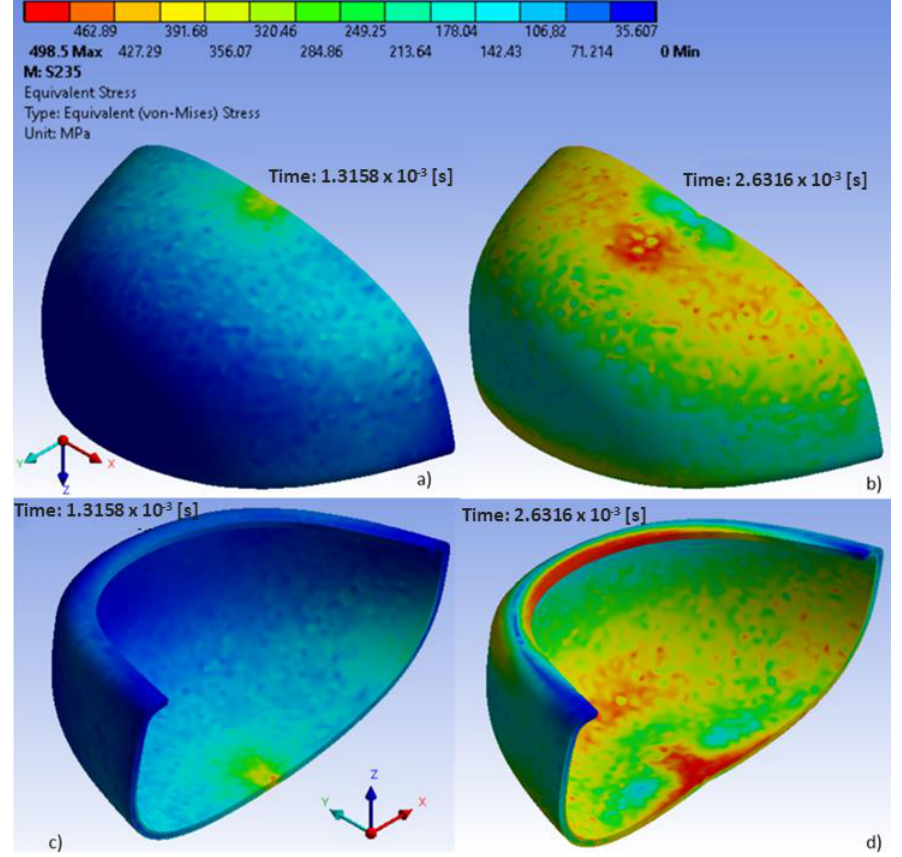
Figure 6. Equivalent stress in steel toecaps at different time steps: ( a , b ) external surface, ( c , d ) internal surface.